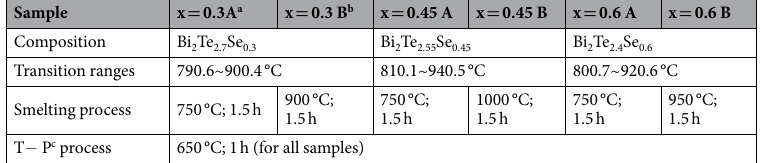
Table 1. Specific sample smelting processes for Bi 2 T 3 − x Se x (x = 0.3, 0.45, 0.6) alloys. These samples are used for investigating the solidification processes and corresponding microstructures and mechanical properties. a A represents smelted at temperatures below the range of TI-LLST. b B represents smelted at temperatures above the range of TI-LLST. c T − P represents